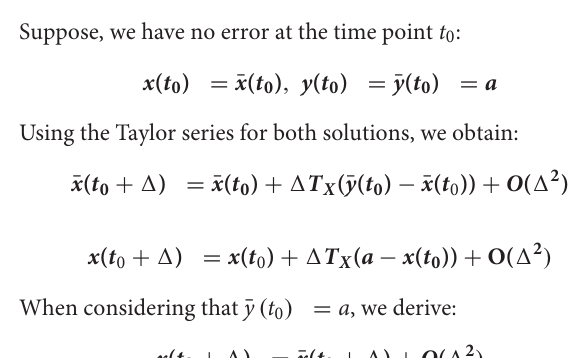
calculations inside each agent involve automatic computation of time steps necessary for required accuracy.